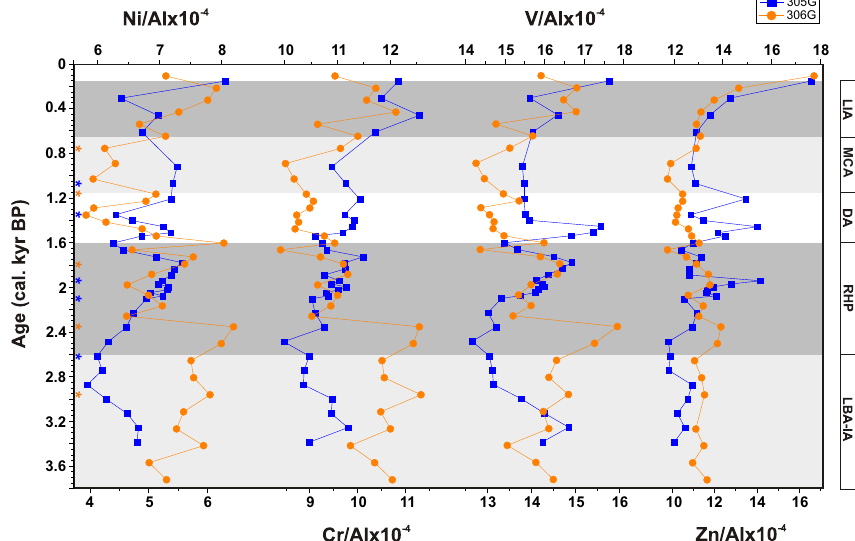
Fig. 8. Age-depth profile of redox proxies (V/Al, Cr/Al, Ni/Al and Zn/Al × 10 − 4 ratios) for cores 305G (blue squares) and 306G (orange circles). Light grey bars indicate dry periods (MCA: Medieval Climate Anomaly, DA: Dark Ages, LBA-IA: Late Bronze Age-Iron Age); dark grey bars indicate humid periods (LIA: Little Ice Age, RHP: Roman Humid Period). Asterisks indicate the AMS 14 C dates.